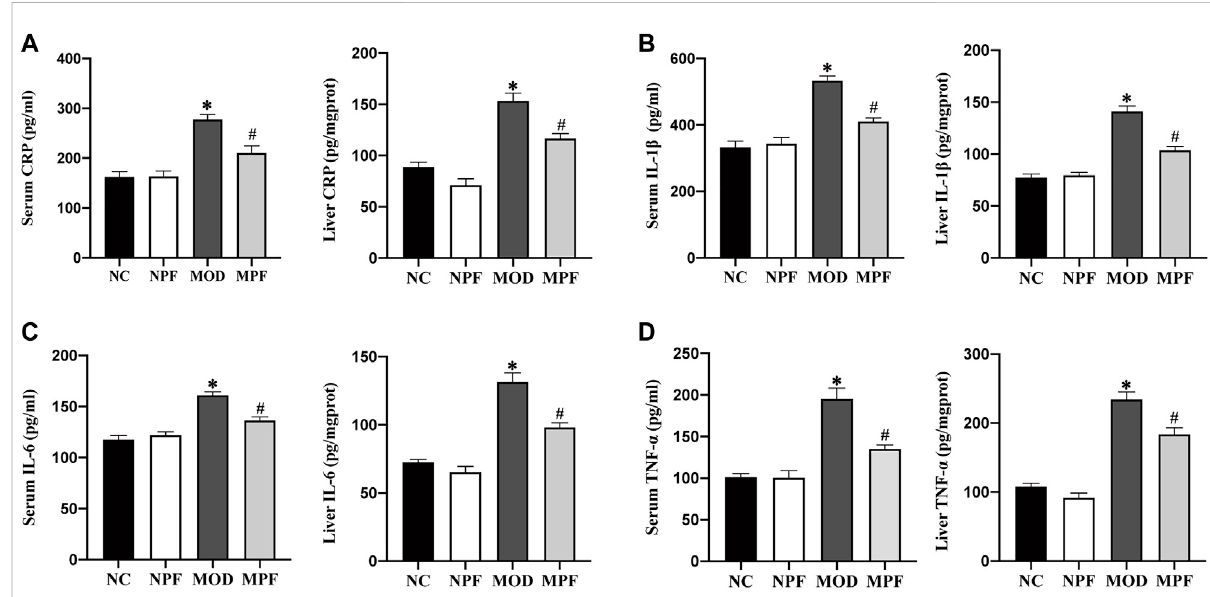
Effects of paeoni fl orin(PF) on in fl ammatorycytokinesintheserum and liver. Serum and liverlevels of (A) CRP, (B) IL-1 β , (C) IL-6, and (D) TNF- α . The serum and liver samples were obtained from the normal control group (NC), PF-treated control group (NPF), model group (MOD), and